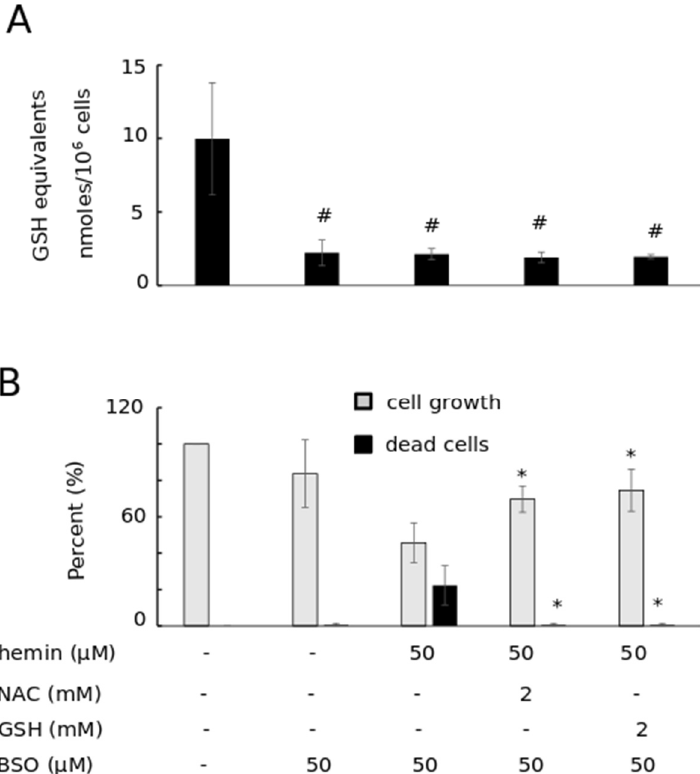
Figure 1. Total GSH equivalent levels, cell growth, and viability in K562 cells treated with the chemical inhibitor of GSH biosynthesis (BSO), in the presence of hemin and/or NAC and/or GSH. K562 cells were pre-incubated with BSO (50 µ M) for 24 h. Thereafter, cells were washed out and re-suspended in cell medium without any further addition or with hemin (50 µ M), or with hemin in presence of NAC and/or GSH (2 mM), and incubated for another 24 h. Afterwards, the quantity of GSH equivalents ( A ), cell growth, and viability ( B ) were determined. Cell growth percentage was calculated relative to K562 cells treated with no agents from the onset of the experiment (cell growth at 100%) and expressed as a percentage. Cell viability was determined as the percentage of trypan blue positive cells in each culture. Statistical differences were shown between cells pre-incubated with BSO and those left untreated ( A ) or cells treated with hemin and BSO and those treated simultaneously with either NAC or GSH ( B ). p values < 0.05(*) and 0.001 (#).